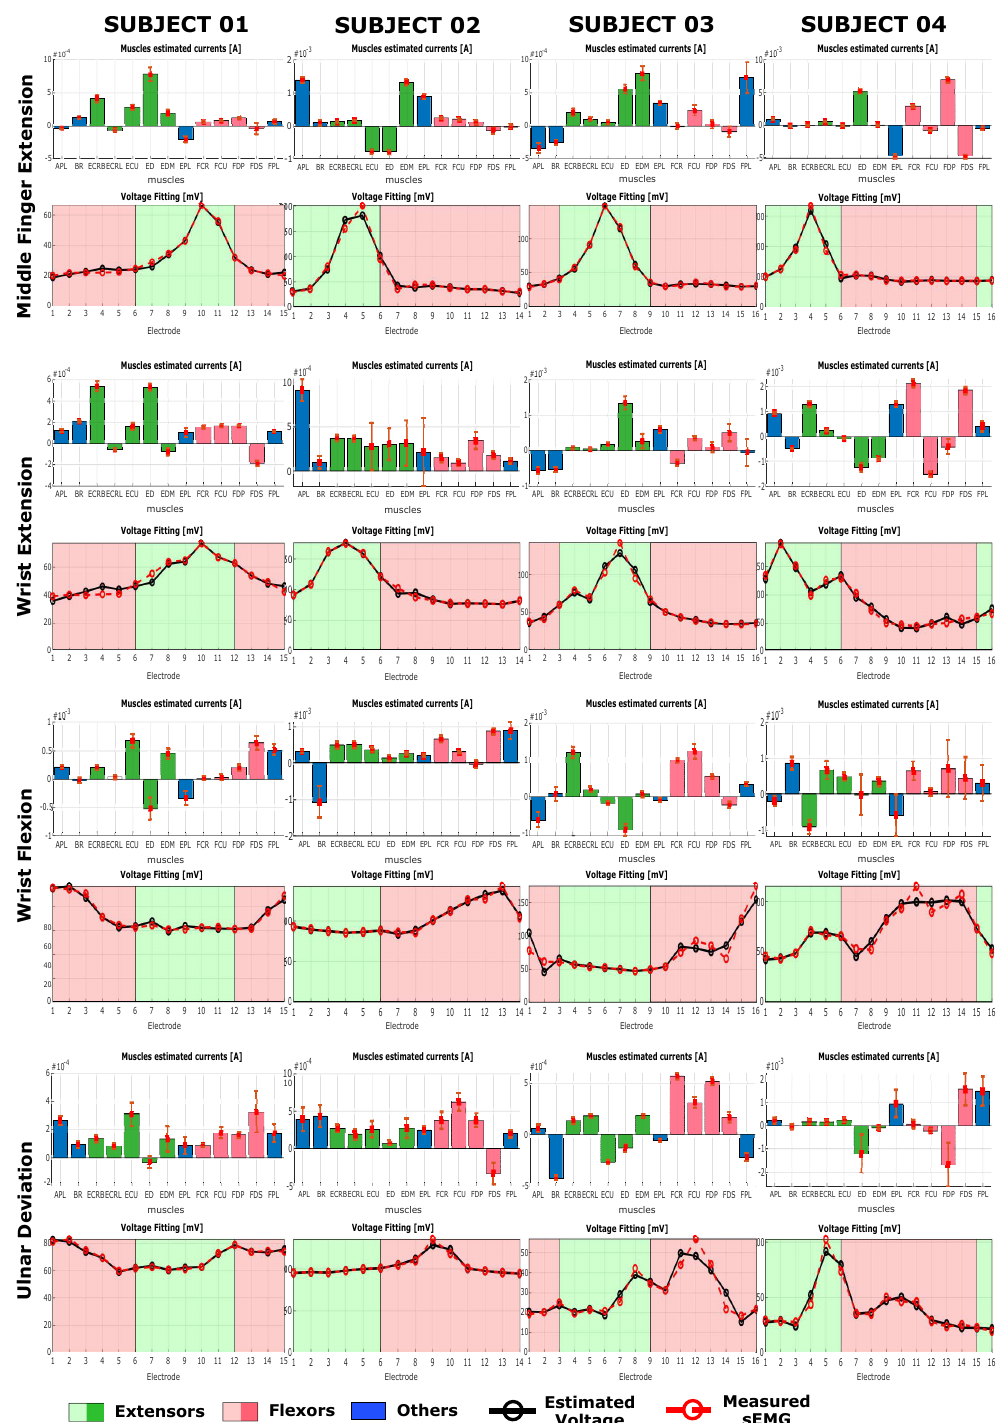
Figure 9. Estimated currents and voltage fitting on the electrodes space for all the tasks considered at 50% of MVC. Each bar represents the average current estimated for a muscle for 11 repetitions. The bar is coloured in green for extensors and in red for flexors. Muscles that are not mainly involved in the considered movements according to anatomy are colored in blue. On the electrodes space, the measured sEMG is represented with a red dotted line, whereas one example of the estimated value is represented with a solid black line. The background color is green for electrodes over the posterior side of the forearm (extensors) and is red for electrodes over the anterior side of the forearm (flexors). For further information on the meaning of the abbreviation of the muscles and their position refer to Figure